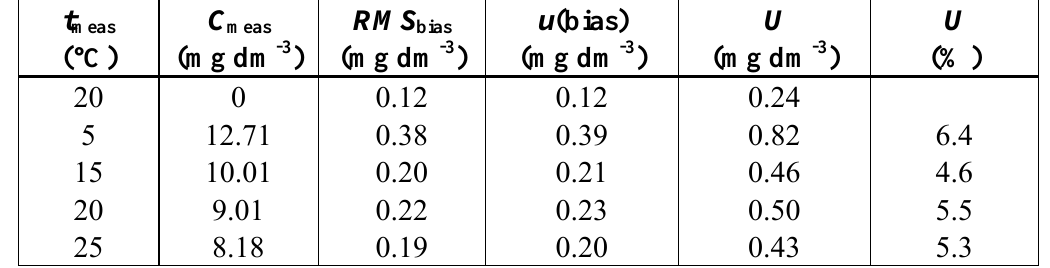
Table 5. The uncertainties of WTW OXI340i with a CellOx 325 sensor by the Nordtest